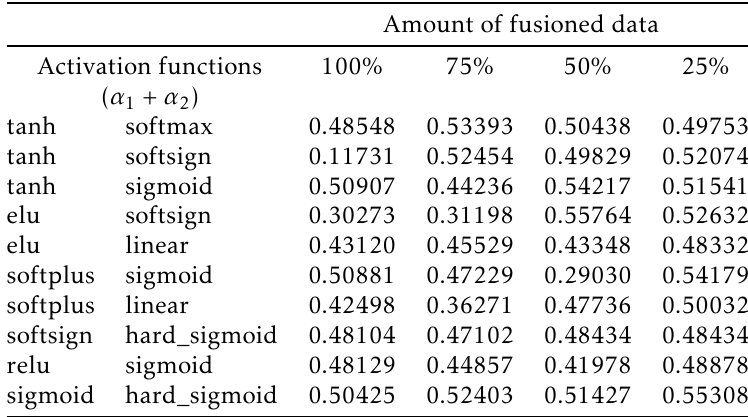
Table 4. Tuple of the ten highest activity recognition model results for Subject 3, which benchmark is 0.31173.